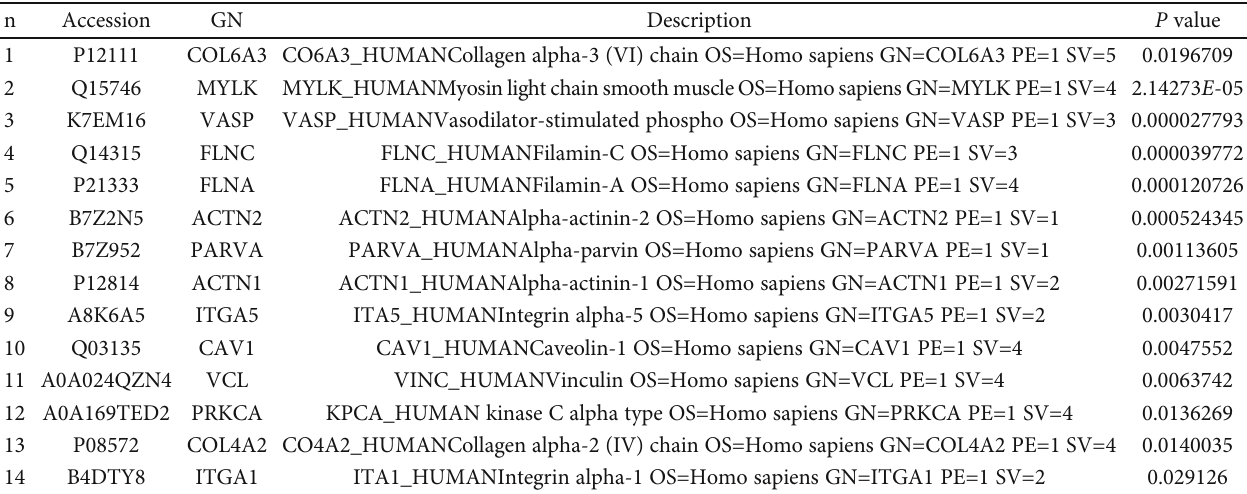
Table 4: The 14 di ff erentially expressed proteins enriched in “ focal adhesion ”